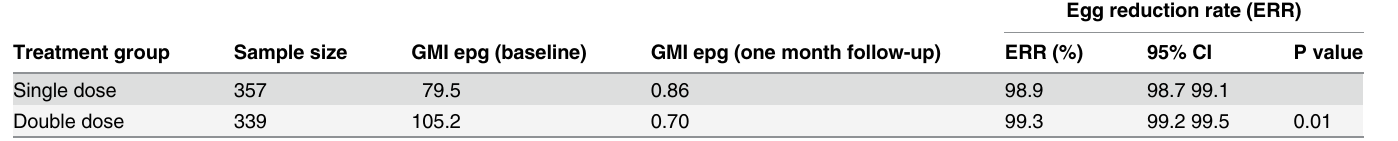
Table 5. Comparison of egg reduction rate between single and double doses assessed 1-month